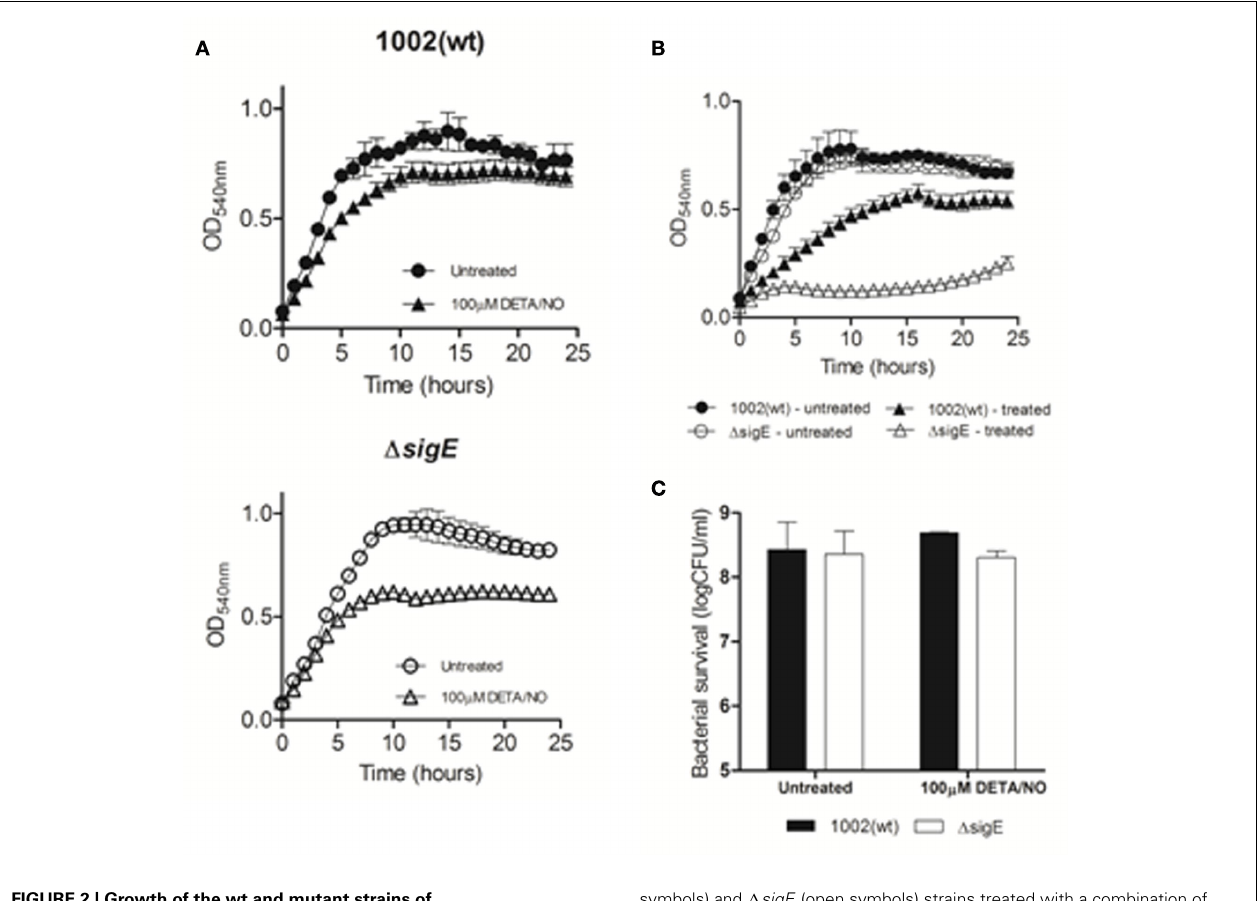
FIGURE 2 | Growth of the wt and mutant strains of C. pseudotuberculosis following exposure to nitric oxide/peroxide stress. (A) Representative growth curves of 1002 and Δ sigE strains exposed to 100 μ M DETA/NO (B) Representative growth curves of 1002 (filled